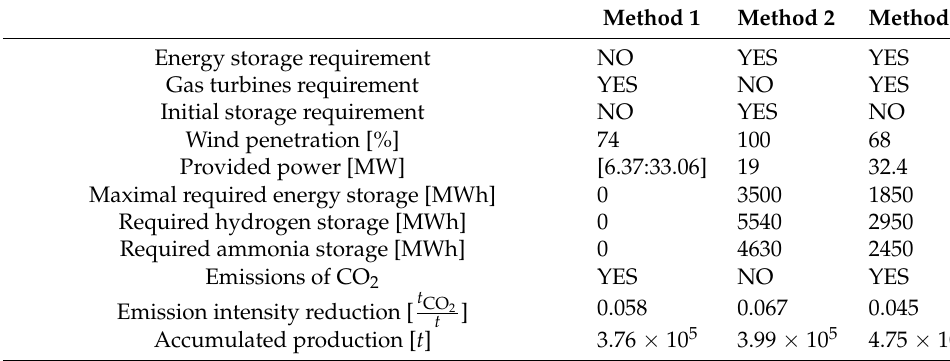
Table 3. Key results of the